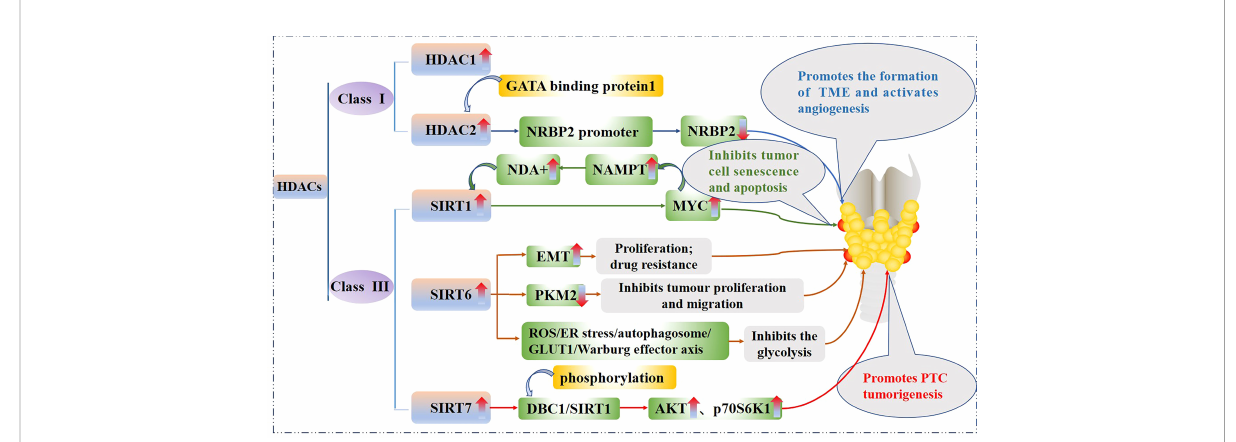
FIGURE 3 Mechanistic pathways of histone acetylation in papillary thyroid cancer. HDAC, Histone deacetyltransferases; NRBP2, Nuclear receptor binding protein 2; SIRT, Sirtuins; NAMPT, Nicotinamide-phosphoribosyltransferase; NAD+, Nicickamide adenine dinucleotide; MYC, Myelocytomatosis oncogene; EMT, Epithelial mesenchymal transition; PKM2, Pyruvate kinase M2; ROS, Active oxygen; ER, endoplasmic reticulum; GLUT1, Glucose transporter 1; DBC1, Promoter of deleted in breast cancer-1; AKT, protein kinase